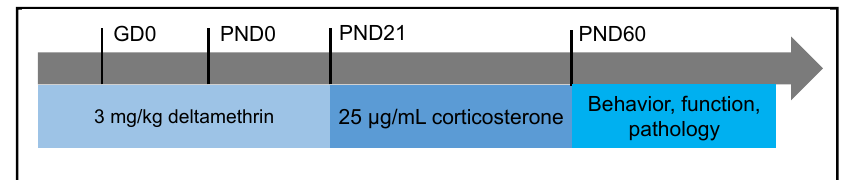
Figure 1. Exposure paradigm timeline. Adult C57BL/6NCrl females were exposed to deltamethrin or vehicle every 3 days during gestation, lactation, and weaning of offspring at postnatal day (PND) 21. Deltamethrin was administered via corn oil dissolved in peanut butter to minimize trauma to pregnant dams. Corticosterone was dissolved in the drinking water to minimize handling stress and reduce variation in CORT levels seen in behavioral chronic stress paradigms.